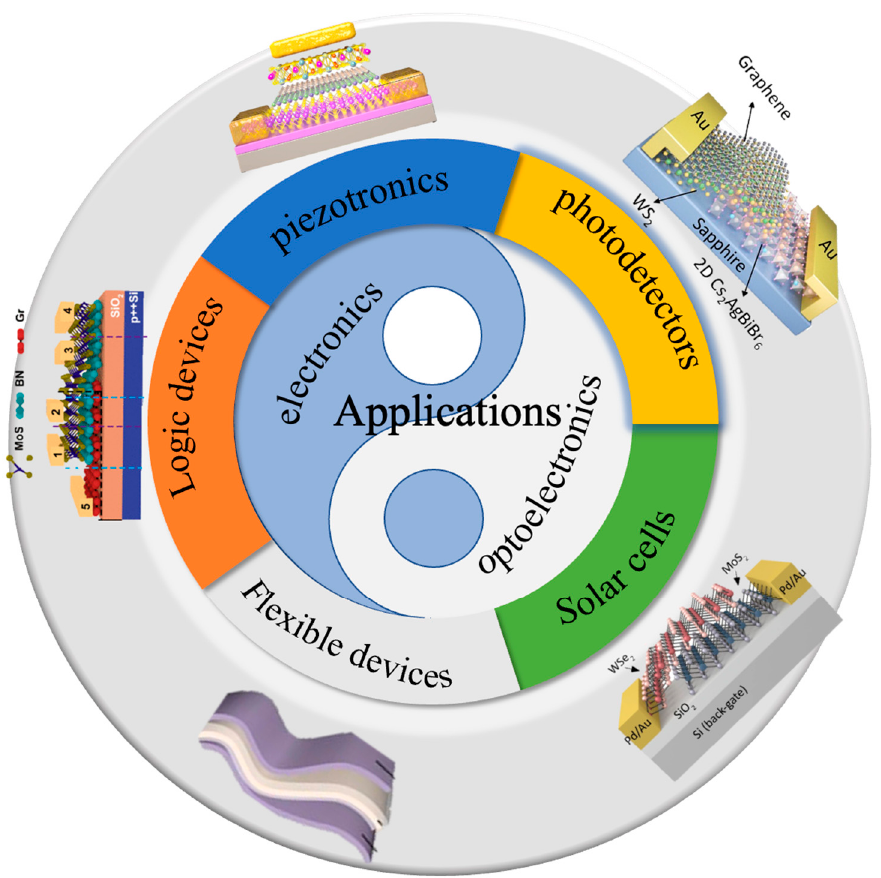
Figure 11. Schematics of primary applications of 2D vdWH. Adapted with permission from [100]. Copyright © 2018, The Author(s). Adapted with permission from [121]. Copyright © 2018, The Author(s). Adapted with permission from [122]. © 2022 Elsevier B.V. All rights reserved. Adapted with permission from [108]. Copyright © 2022, American Chemical Society. Adapted with permission from [151]. Copyright © 2021, The